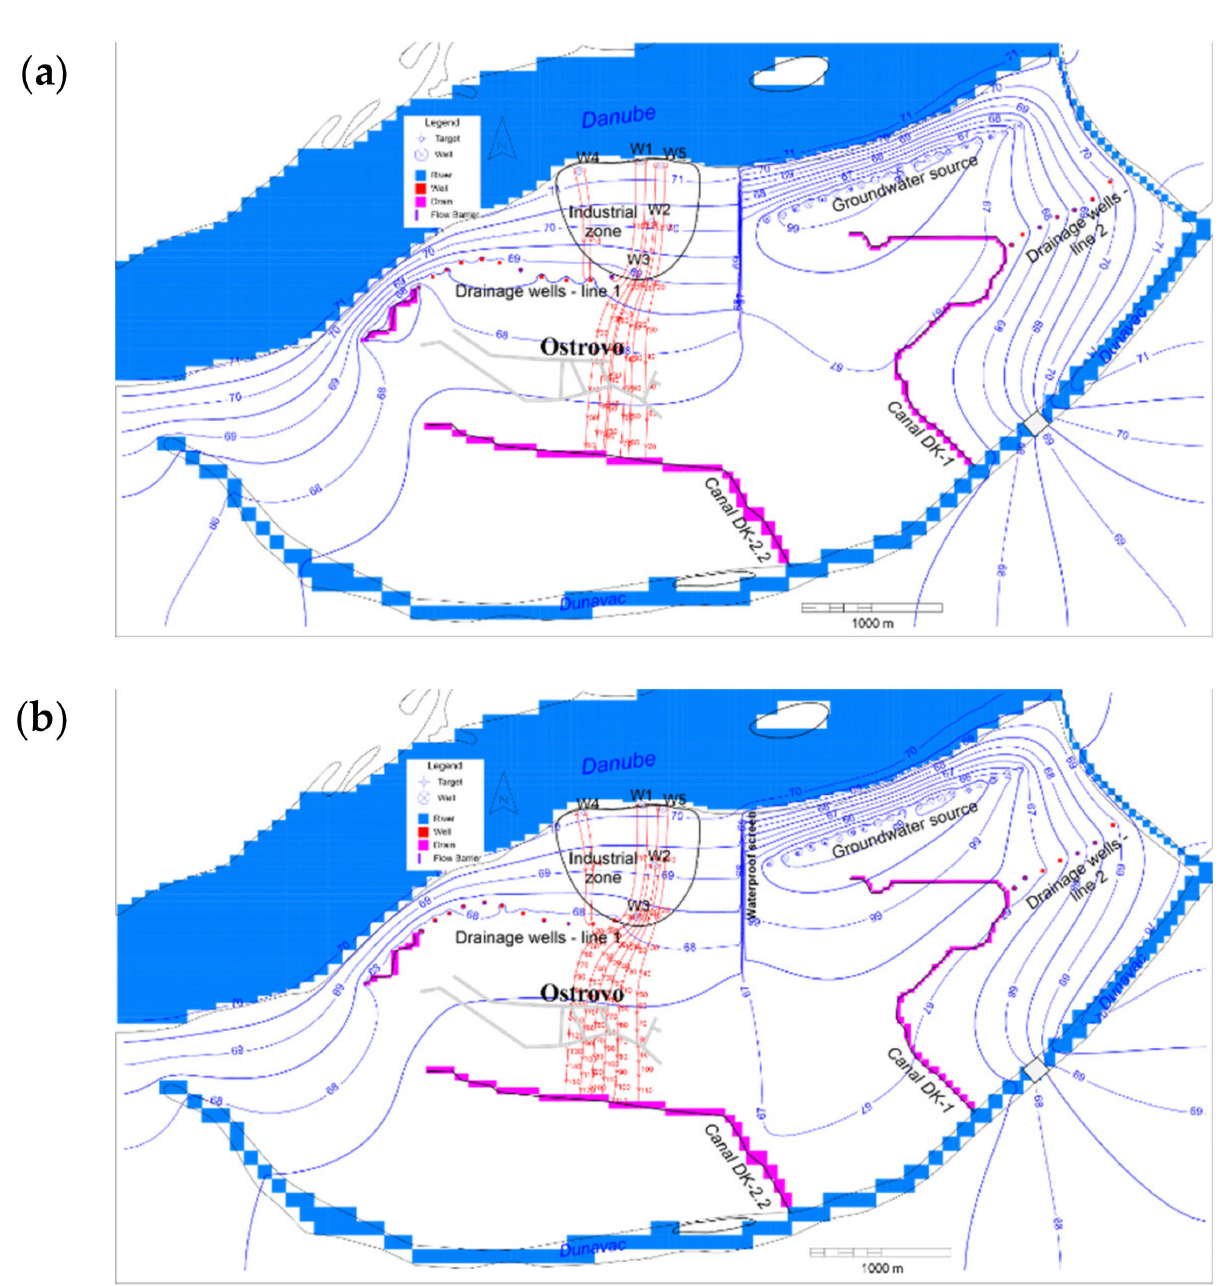
Figure 17. Flow pattern of Plan 2 (waterproof screen) at the ( a ) high and ( b ) low stages of the Danube recorded in 2015 (second model